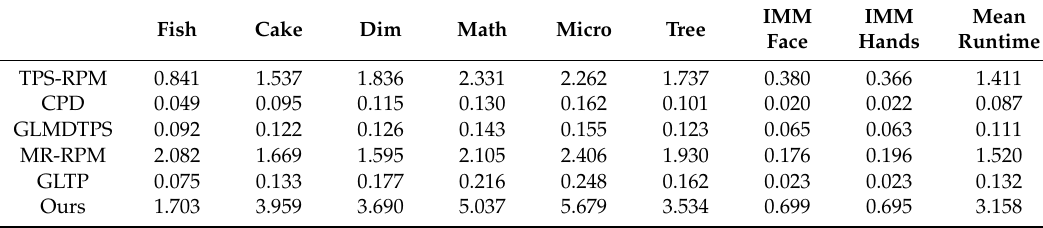
Table 1. Runtime(s) of point set registration methods on di ff erent